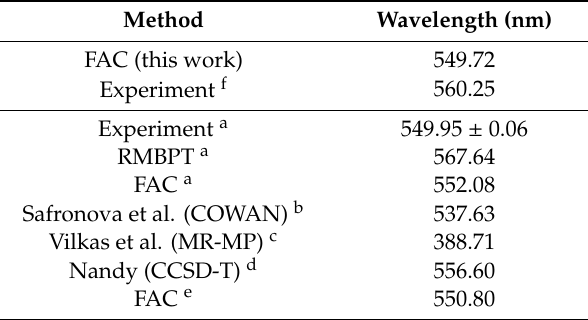
Table14. Comparisonoftransitionwavelength(nm)calculatedwithFACforthetransition4f 13 5s 2 2 F 5 / 2 - 2 F 7 / 2 with other results for Pm-like W. Experimental wavelengths are given in standard air, while theoretically calculated wavelengths are in